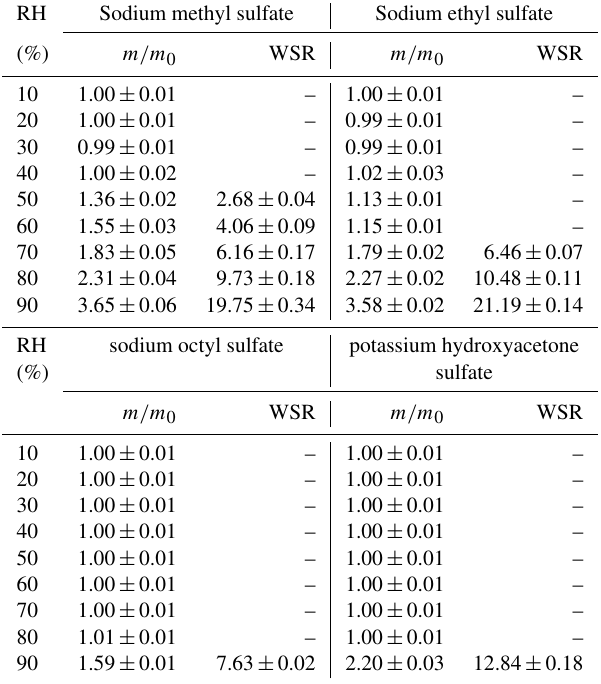
Table 1. Mass growth factors ( m/m 0 ) and water-to-solute ratios (WSRs) as a function of RH (10%–90%) at 25 ◦ C for sodium methyl sulfate, sodium ethyl sulfate, sodium octyl sulfate and potas- sium hydroxyacetone sulfate. All the errors given in this work are standard